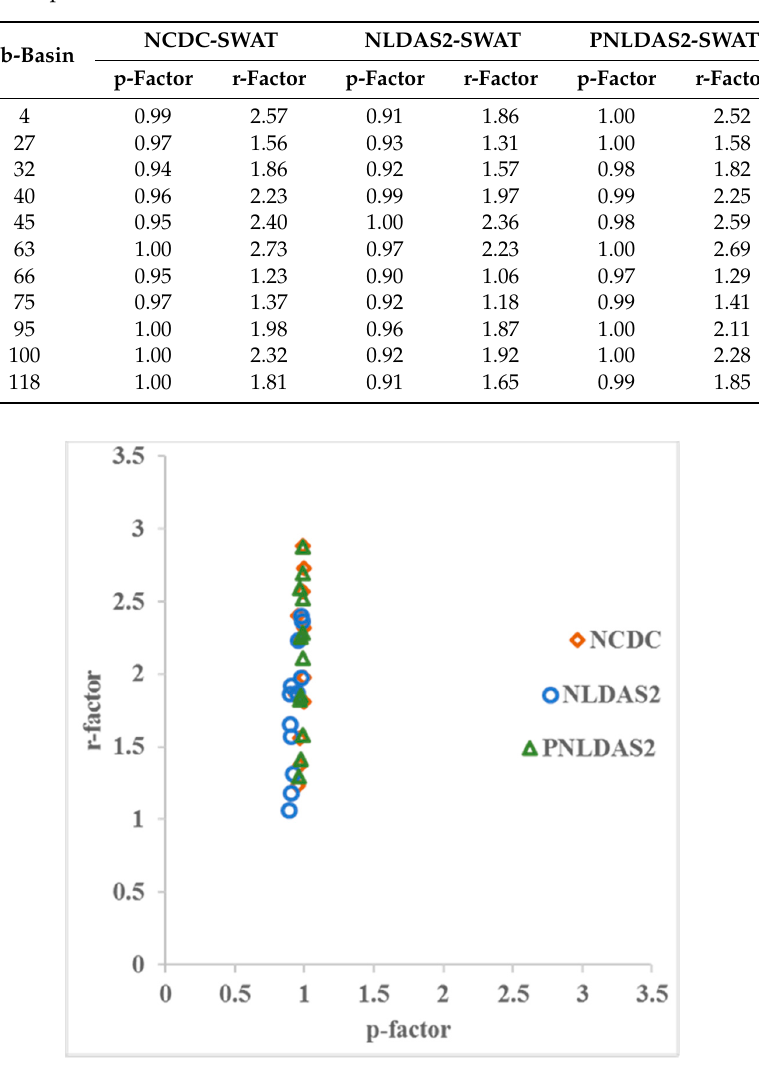
Figure 5. Scatter plot for p-factor and r-factor for different sub-basin in three simulation scenarios.